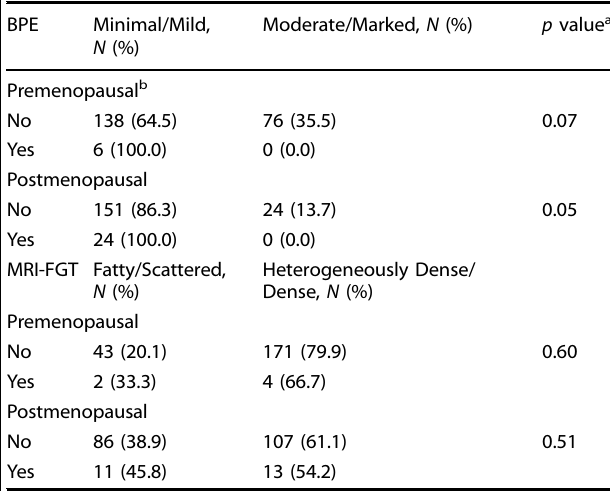
Table 6. Distribution of BPE and MRI-FGT by preventive medication use at the time of MRI in pre- and postmenopausal